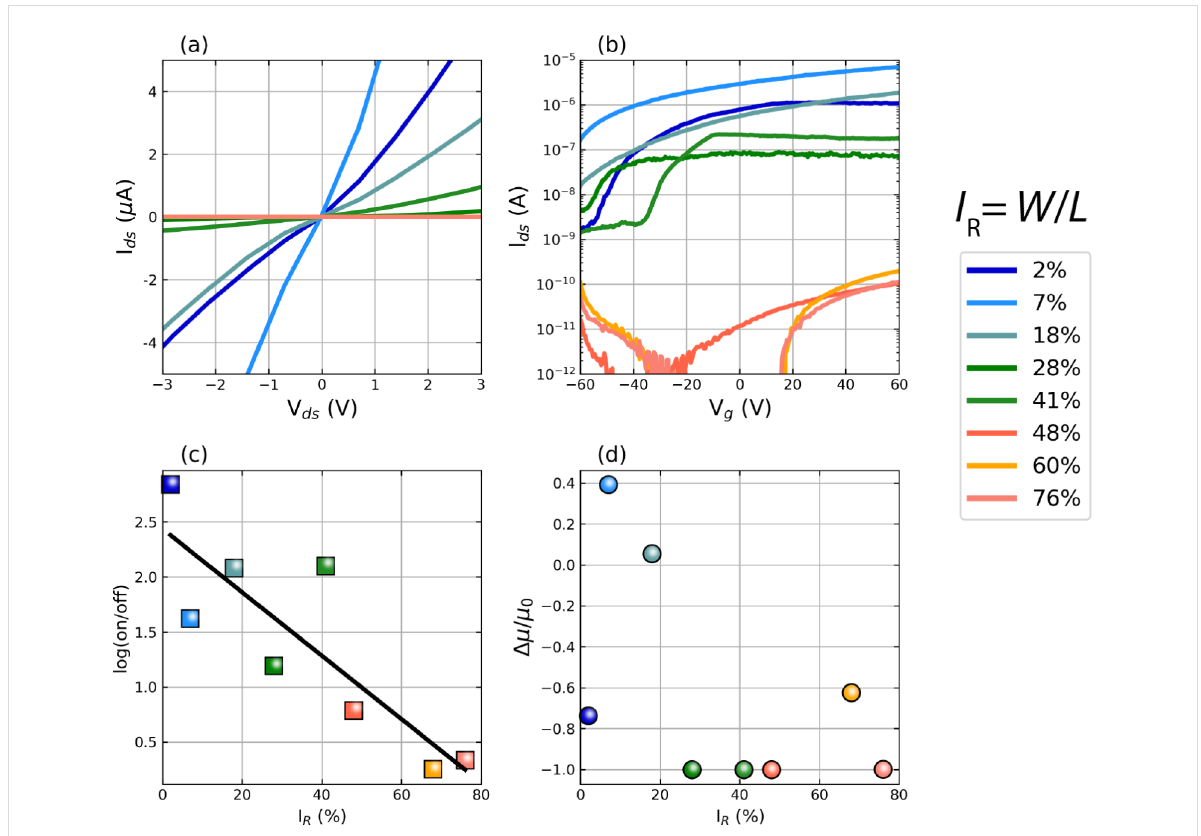
Figure 2: Effects of changing the irradiated area on the performance of monolayer MoS 2 FETs. Note that all the plots share the same color legend on the right. (a) I – V and (b) gate sweeps of different devices with varying I R . (c) Semi-log plot of the extracted electron branch on/off ratios correspond- ing to each gate curve in (b). The black line is a linear fit to the semi-log data. (d) Changes in the field-effect mobility, μ , relative to as-made device mobilities, μ 0 , extracted from transfer curves in